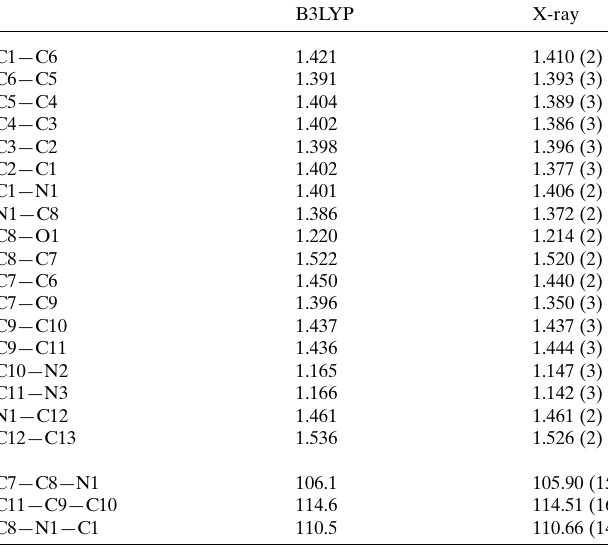
Table 1 The B3LYP-optimized and X-ray structural parameters for 1 (A˚ , (cid:3) ). C1—C6